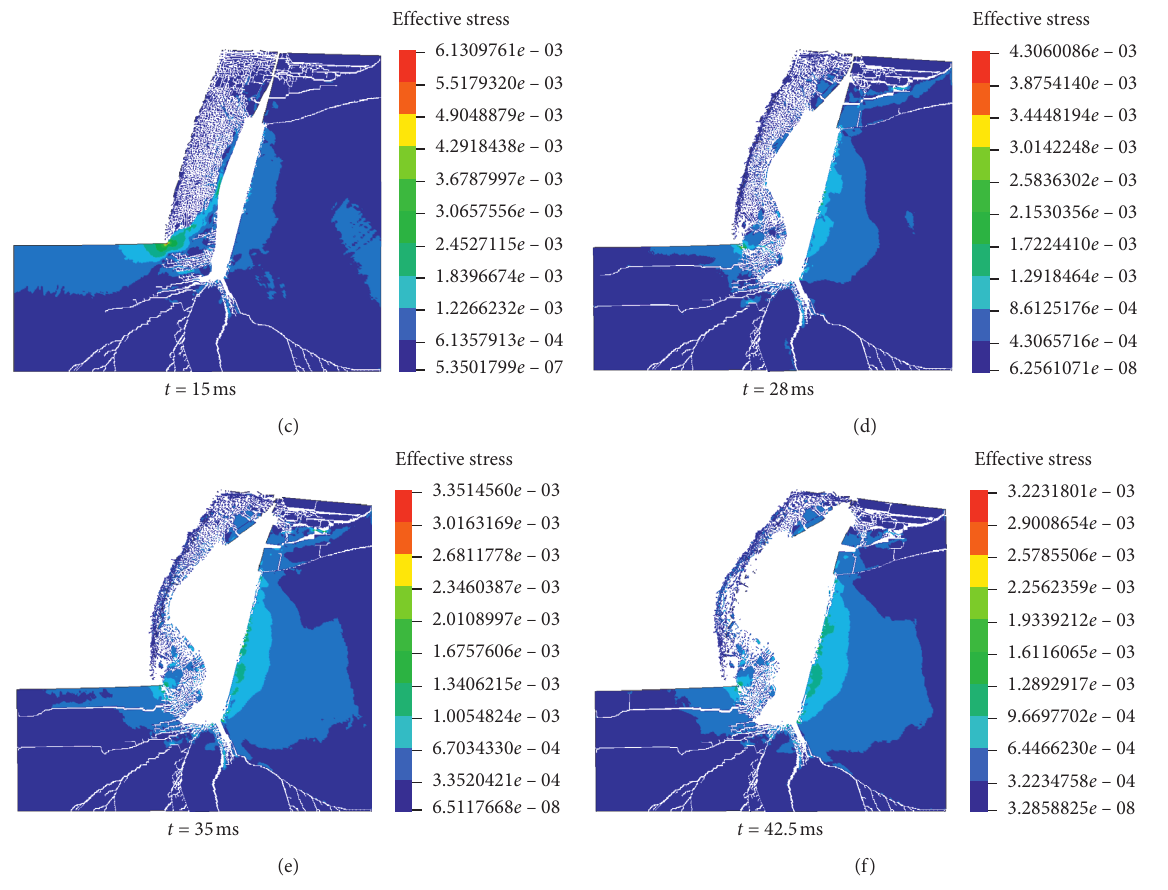
Figure 8: Variety of damage and deformation of the rock at different